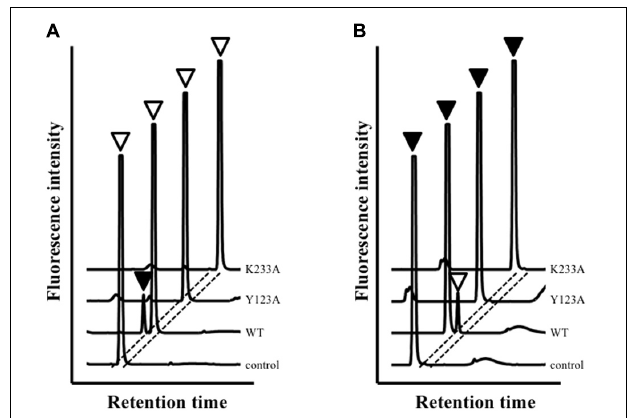
FIGURE 4 | High-performance liquid chromatography (HPLC) analysis of racemase reaction toward L -Ala (A) and D -Ala (B) . White and black arrowheads indicate L -Ala and D -Ala peaks, respectively.